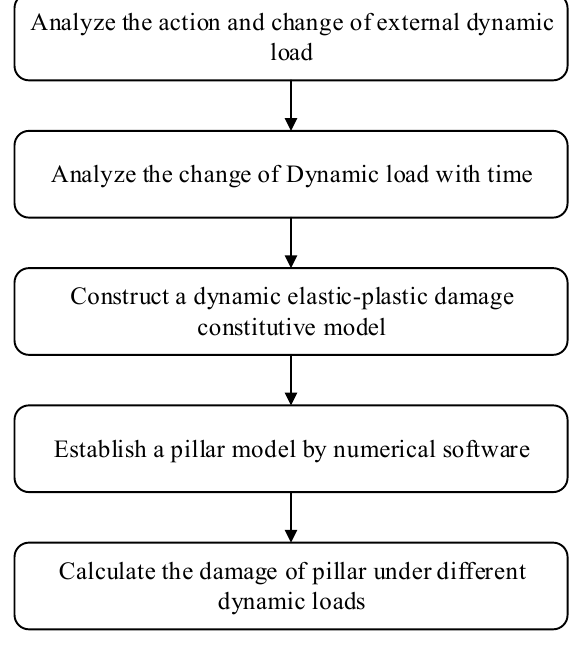
Figure 10. Salt pillar under the dynamics